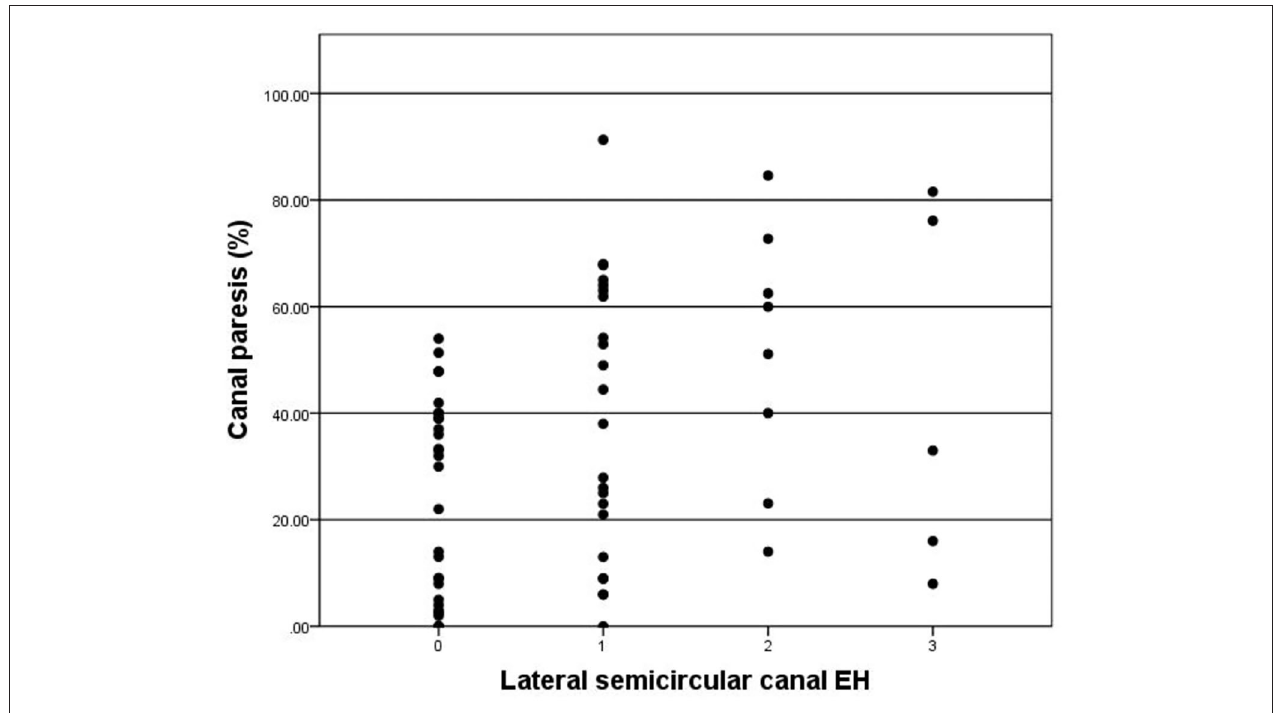
FIGURE 5 | Correlation between grade of lateral semicircular canal EH (x-axis) and CP (y-axis). The positive correlation is significant ( r = 0.367, p = 0.003).